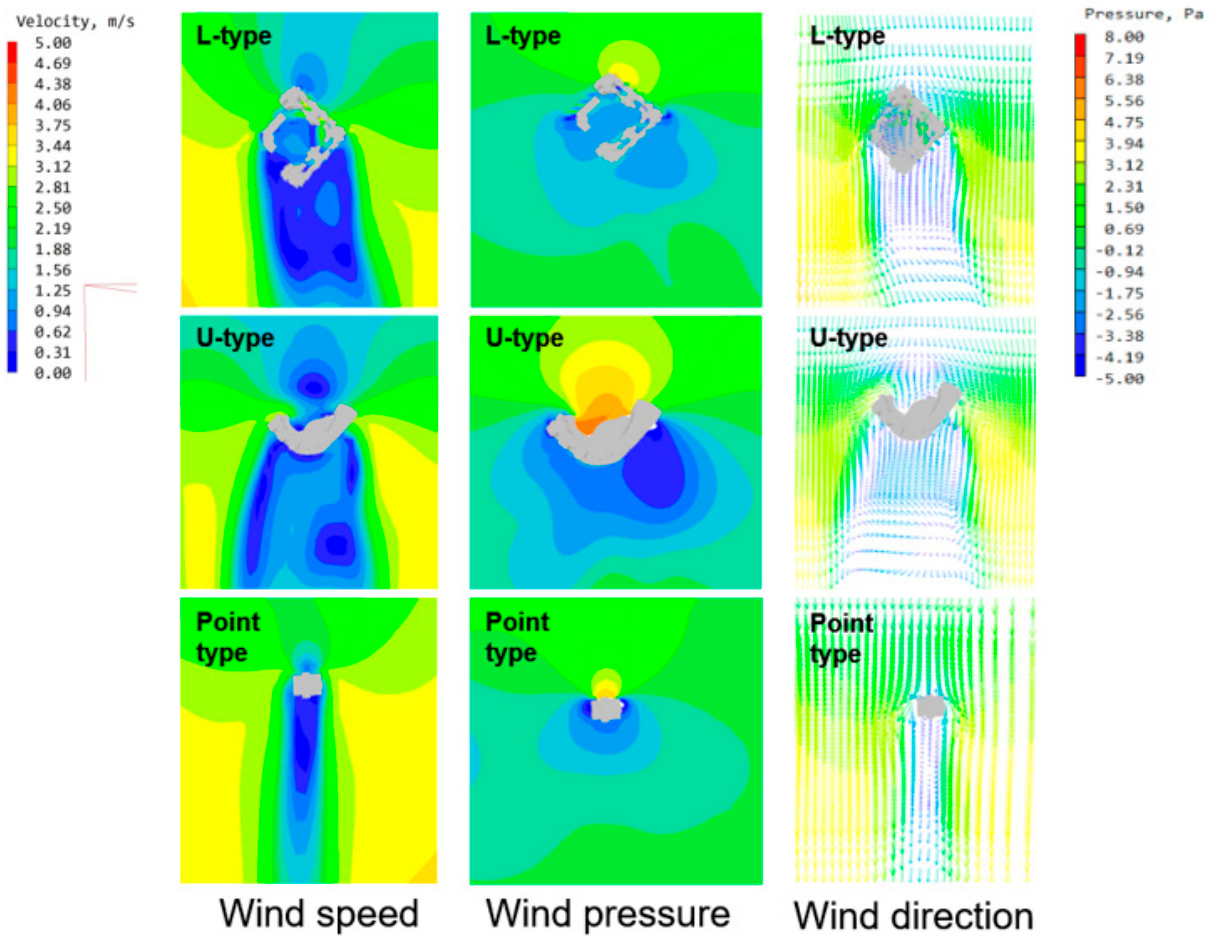
Figure A10. Schematic diagram of typical plane measuring point locations.